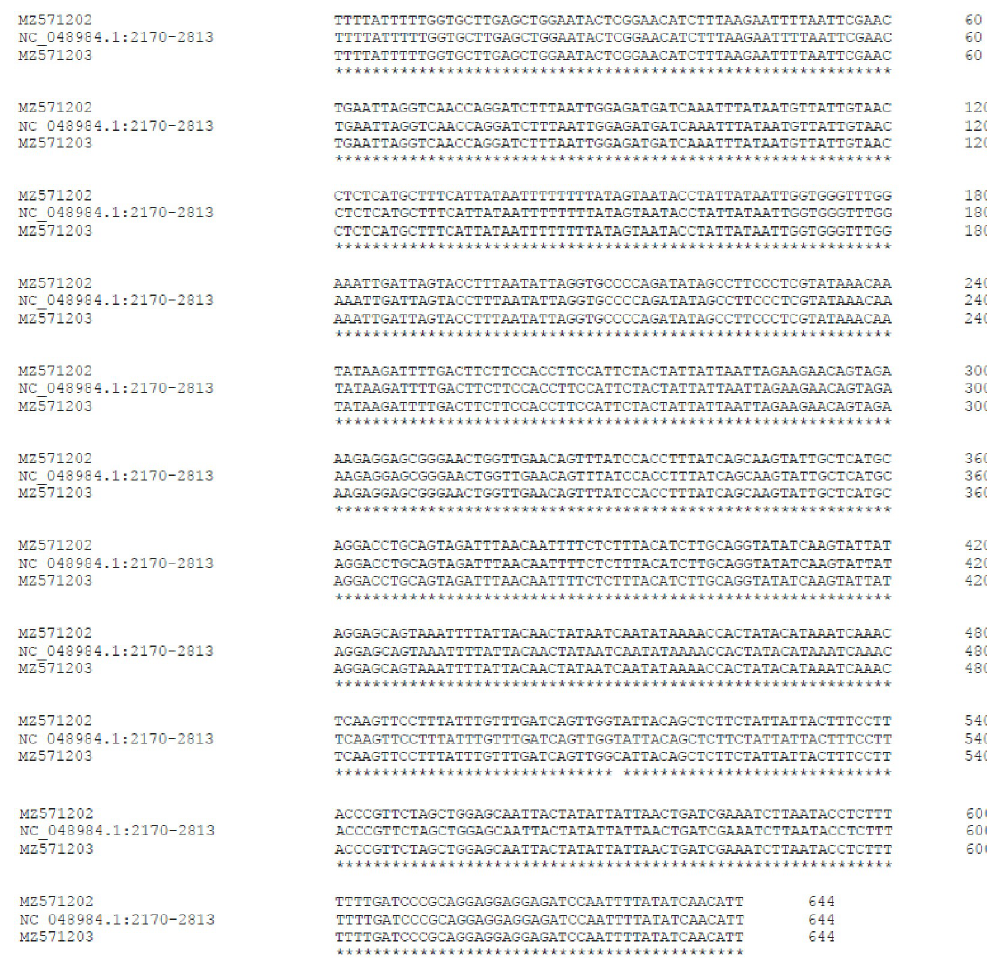
Fig 1. Alignment of nucleotides 2170 to 2813 of NC_048984.1 (complete mitochondrial genome sequence of H . membranacea ) to MZ571202 (isolate from mantid obtained from US provider) and MZ571203 (isolate from mantid obtained from German provider). The MZ571202 isolate was 100% identical to the sequence of NC_048984.1, and the MZ571203 isolate varied at one base and therefore was > 99% identical.